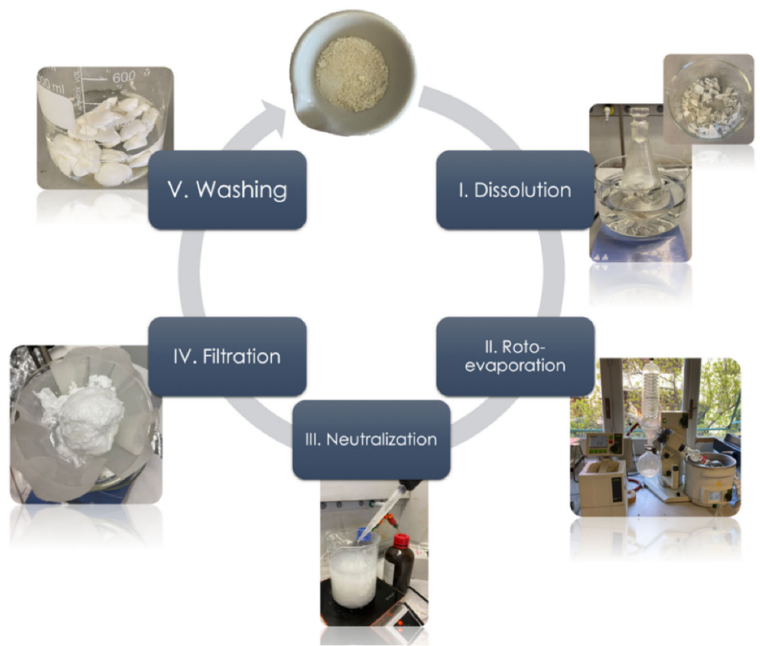
Figure 1. Main steps of the chemical recycling process.